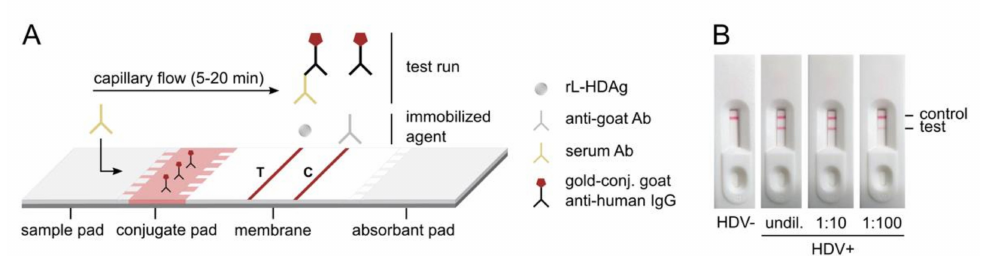
Figure 2. Principle of the HDV rapid test. ( A ) Schematic of the lateral flow assay for the detection of anti-HDV in patient serum. ( B ) Proof-of-principle of the HDV rapid test using anti-HDV-positive and -negative patient